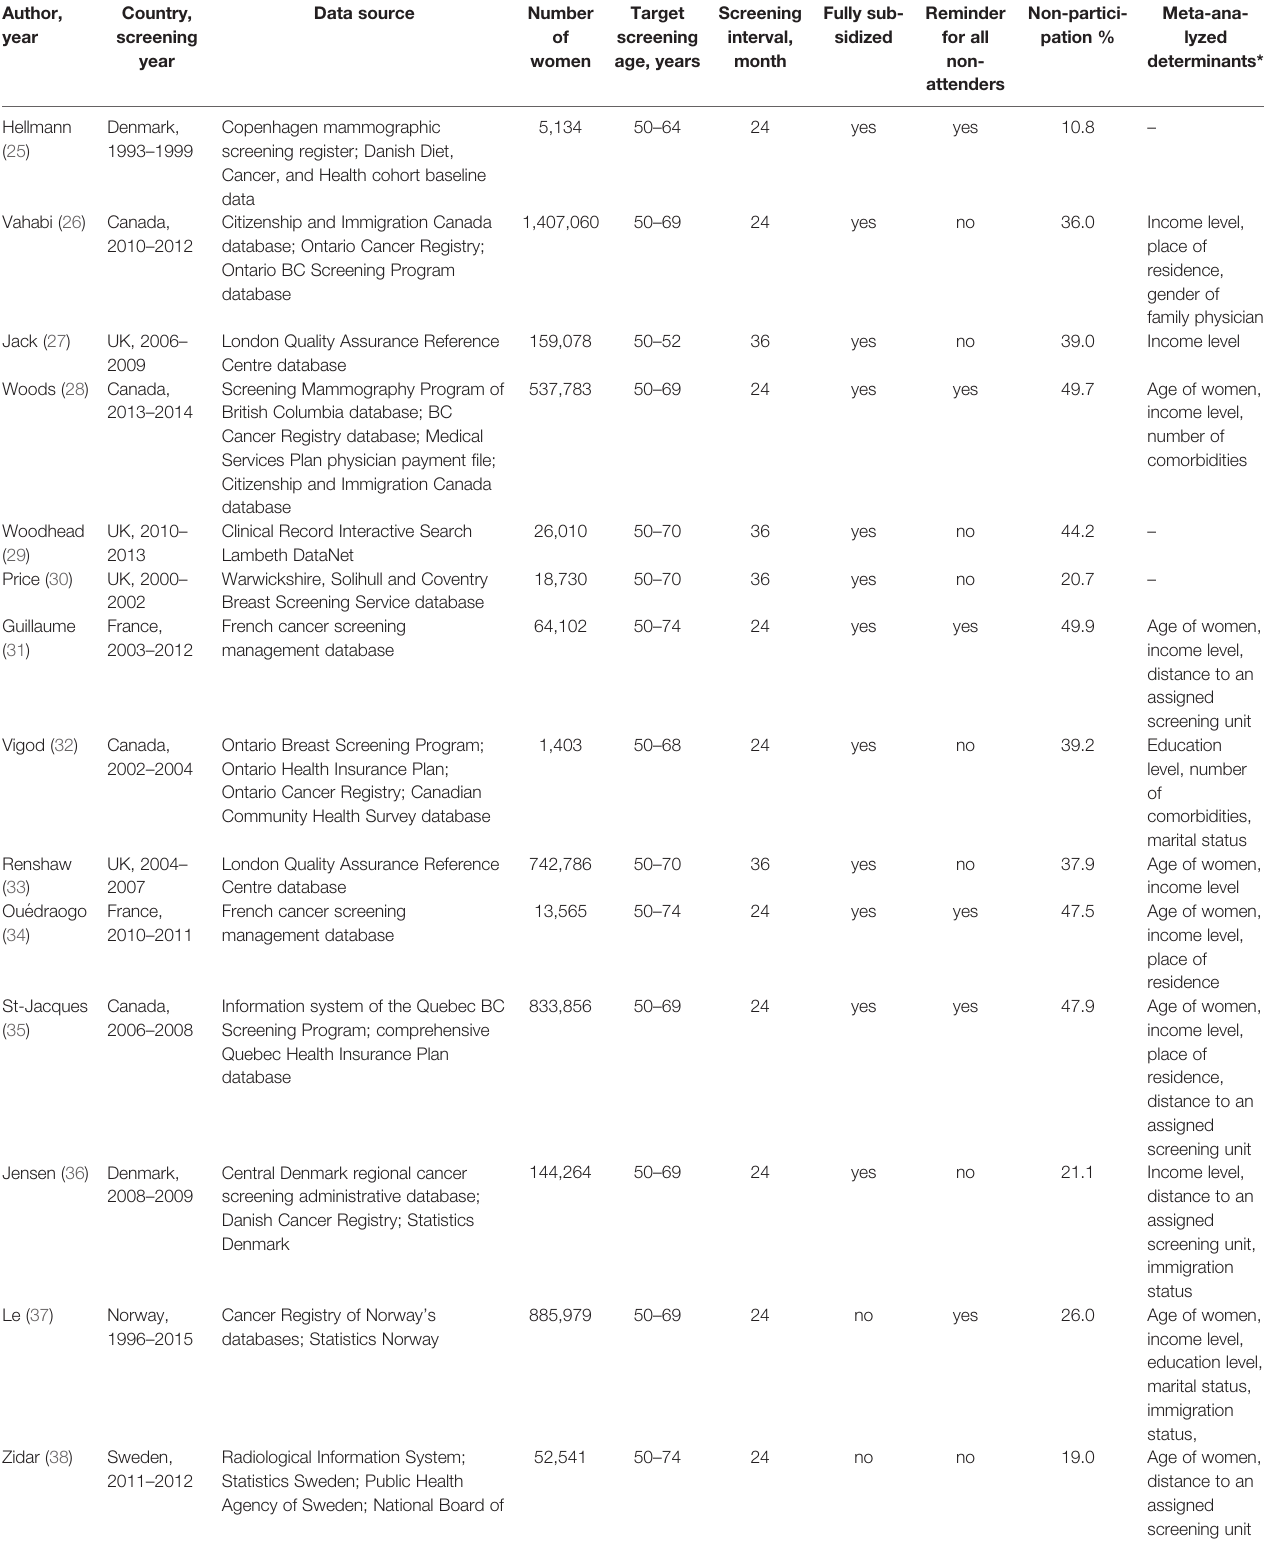
TABLE 1 | Characteristics of the included